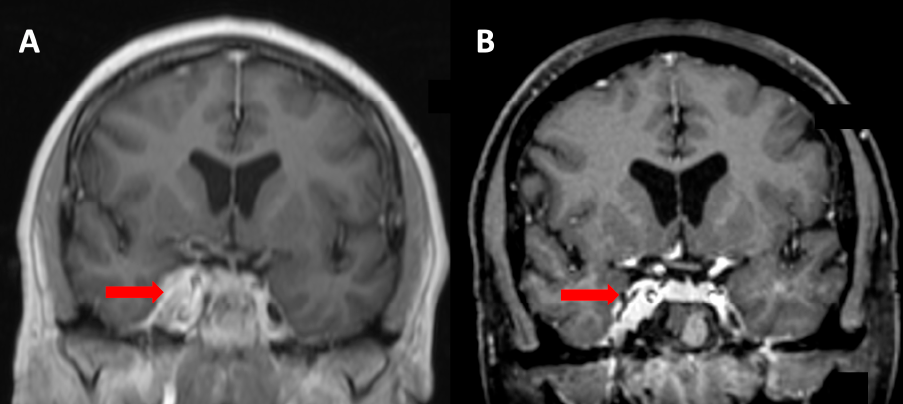
Figure 3. Meningeoma (red arrow) of Patient 1 infiltrating the cavernous sinus and optic canal with encasement of the right internal carotid artery ( A ). Tumor volume regression of 28% noted at final MRI follow-up ( B ).